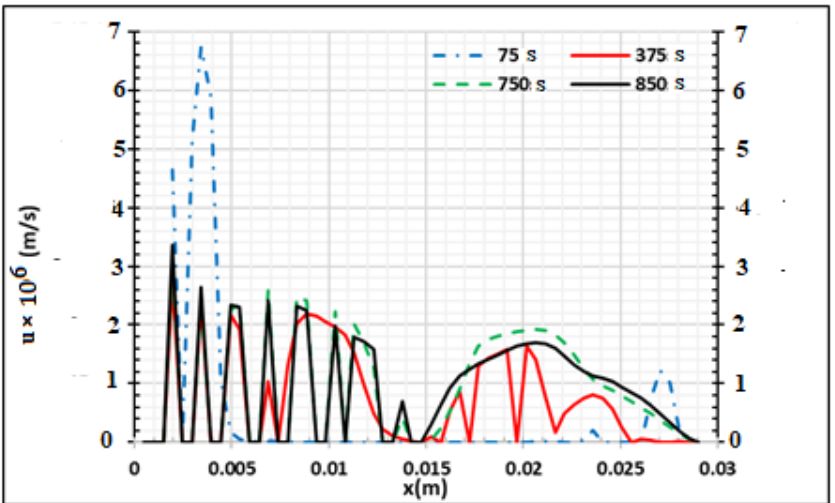
Figure 10. Tar and gas velocity distribution at T f = 973.15 K using samples of 30 mm thickness at four process times, ρ bo = 700 kg/m 3 .